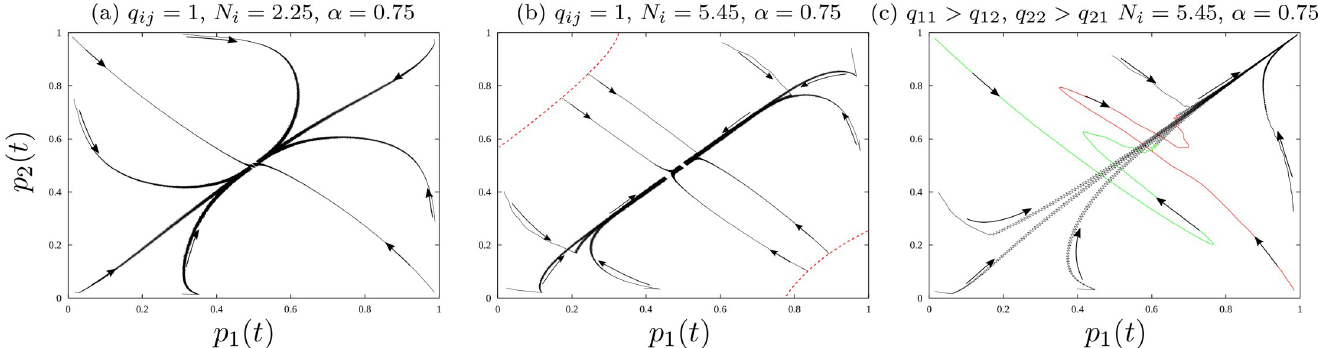
Fig 8. Phase plane analysis of spatial effort allocation; red curves illustrate the initial conditions in the p 1 − p 2 space in which foragers do not consistently meet , even though the system converges to a mixed state. As population density increases from (a) to (b), the initial conditions in p 1 − p 2 space their resource target h m from which foragers can consistently meet their resource target h m declines. Graphs (c) illustrates the effect of territorial ownership. Territorial ownership enlarges the initial conditions in p 1 − p 2 space from which foragers can meet their resource target. In graphs (a)–(c), the amplitude of variation in x 1 & x 2 is held constant at α = 0.75. To define the red curves in Fig 7b, we ran 50 numerical experiments varying p 1 and p 1 holding all parameters equal and the initial conditions of x 1 = 0.3 and x 2 = 0.8 in all